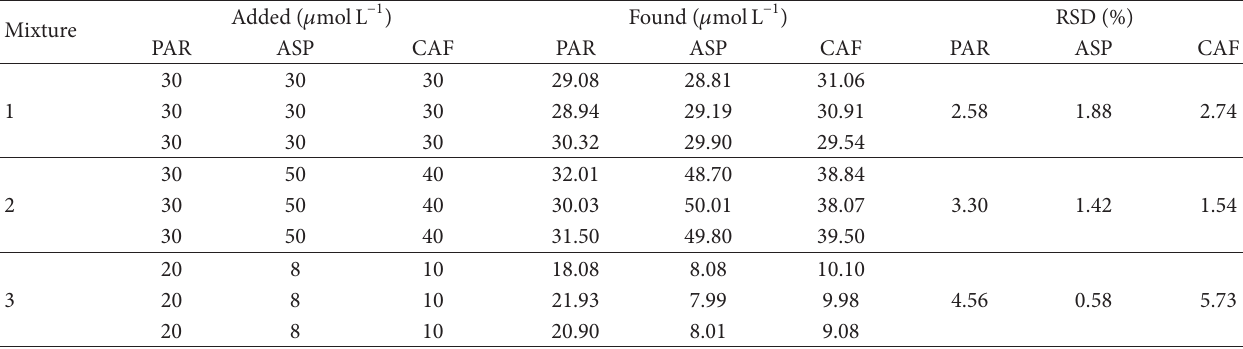
F 6: Effect of pH on the sensitivity (a) and selectivity (b) of the spectra of ASP, CAF, and PAR. All of the conditions are as Figure 1. T 1: Replicative determination of paracetamol, aspirin, and caffeine in some ternary mixtures by double divisor-ratio spectra derivative